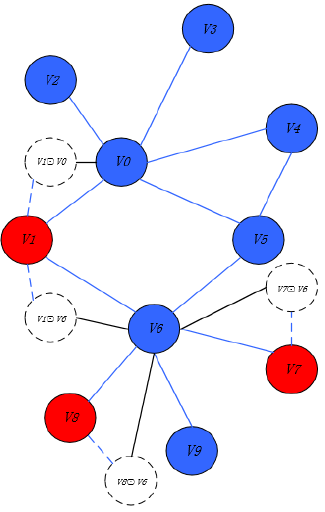
Figure 2. An example of potential neighbors of a site in the edge graph.